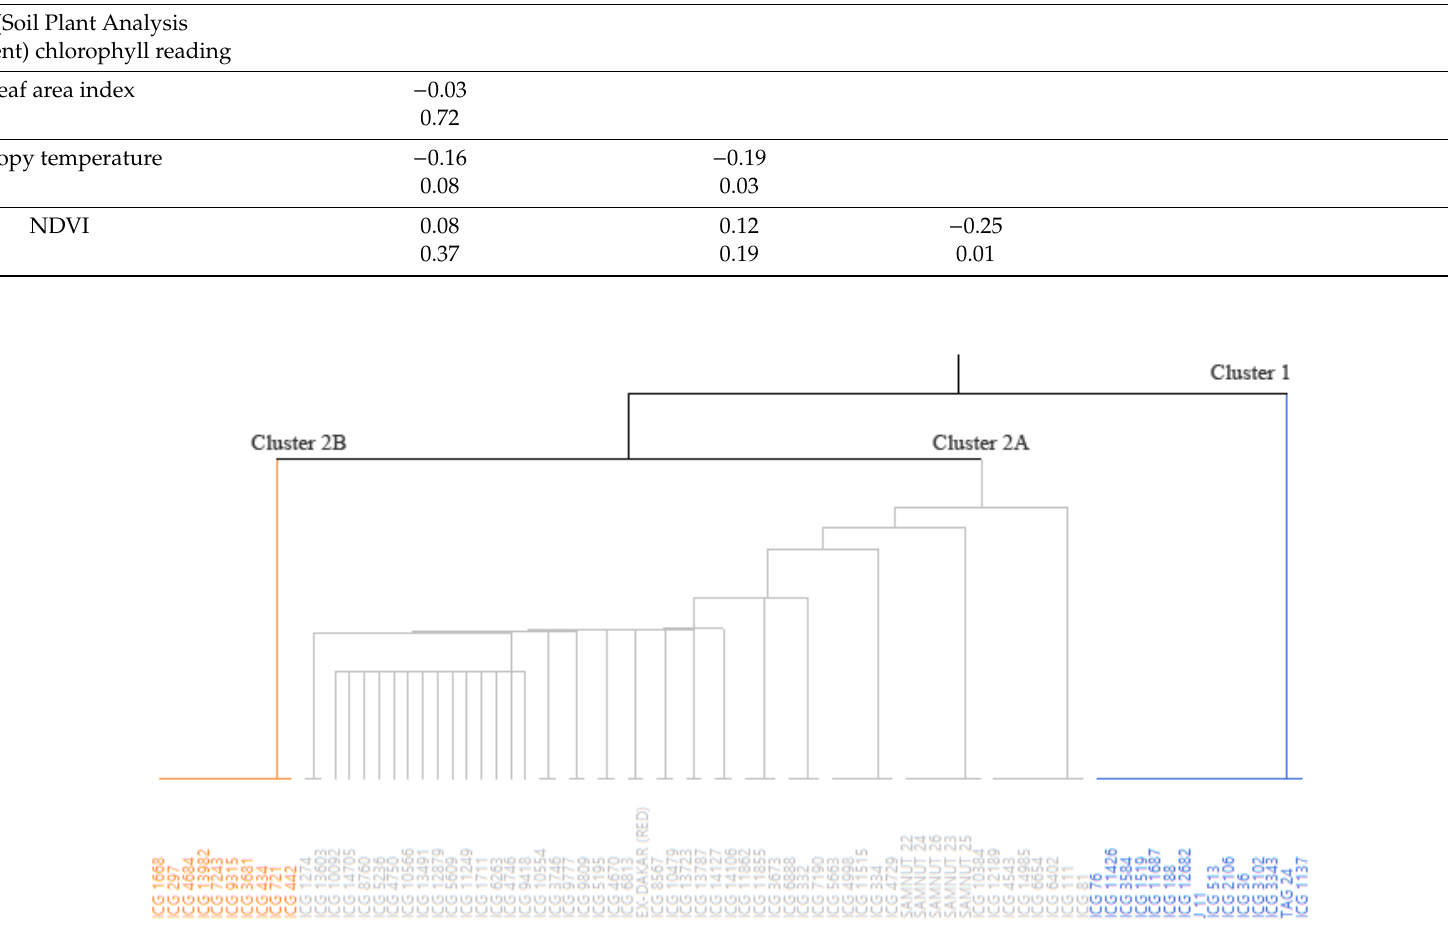
Figure 1. Dendrogram from unweighted pair-group clustering of accession based on the geographical distribution of the mini core collections.